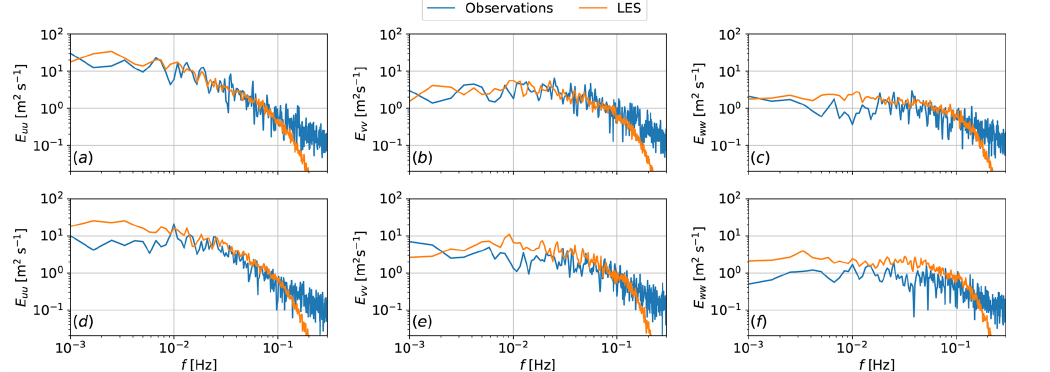
Figure 3. Comparison of power spectra of the three turbulence components (a, d) u , (b, e) v , and (c, f) w for (a–c) the first hour and (d–f) the last hour of the period of interest at 80m using 15min Hamming